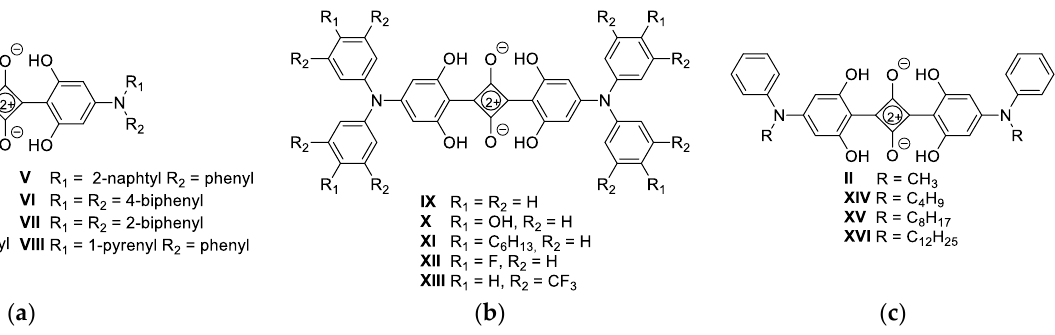
Figure 1. Structures of the previously investigated squaraines: alkyl and aryl anilinosquaraines I – VIII ( a ); diarylsquaraines IX – XIII ( b ); and alkylarylsquaraines II and XIV – XVI ( c ).